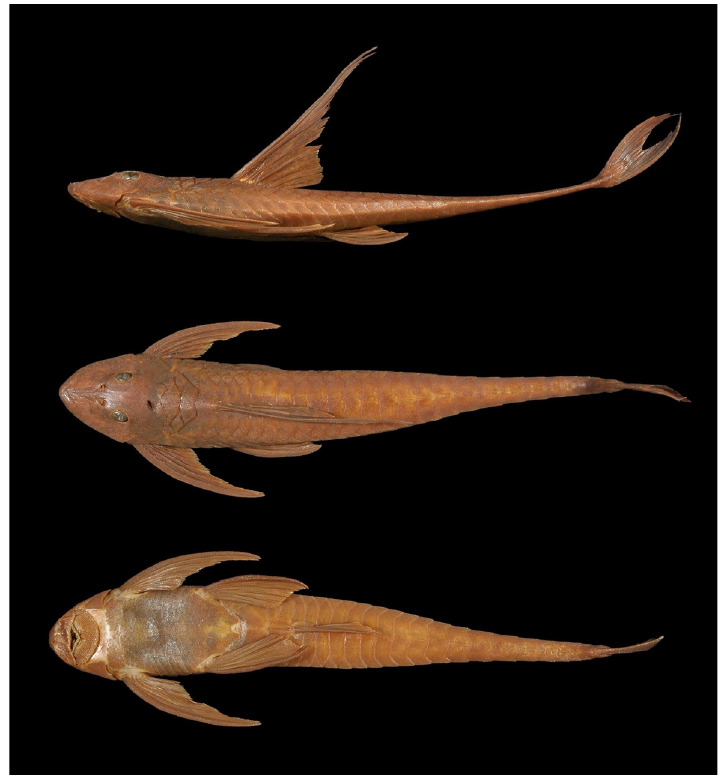
FIGURE 3 | Loricaria platystoma , BMNH 1866.8.14.124, lectotype, 171.5 mm SL, Suriname. Photo by Mark Allen (WAM; ACSI Images